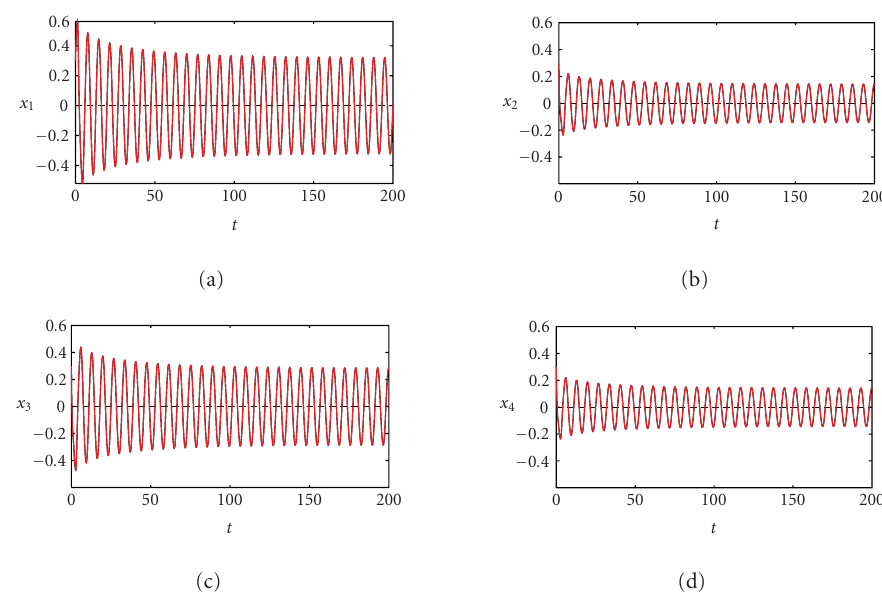
Figure 5.3. The trajectories graphs of system (5.14) with τ 1 = 1 . 2, τ 2 = 1 . 3, and initial data x 1 ( t ) = x 2 ( t ) = x 3 ( t ) = x 4 ( t ) = 0 . 3, t ∈ [ − 1 . 3,0].